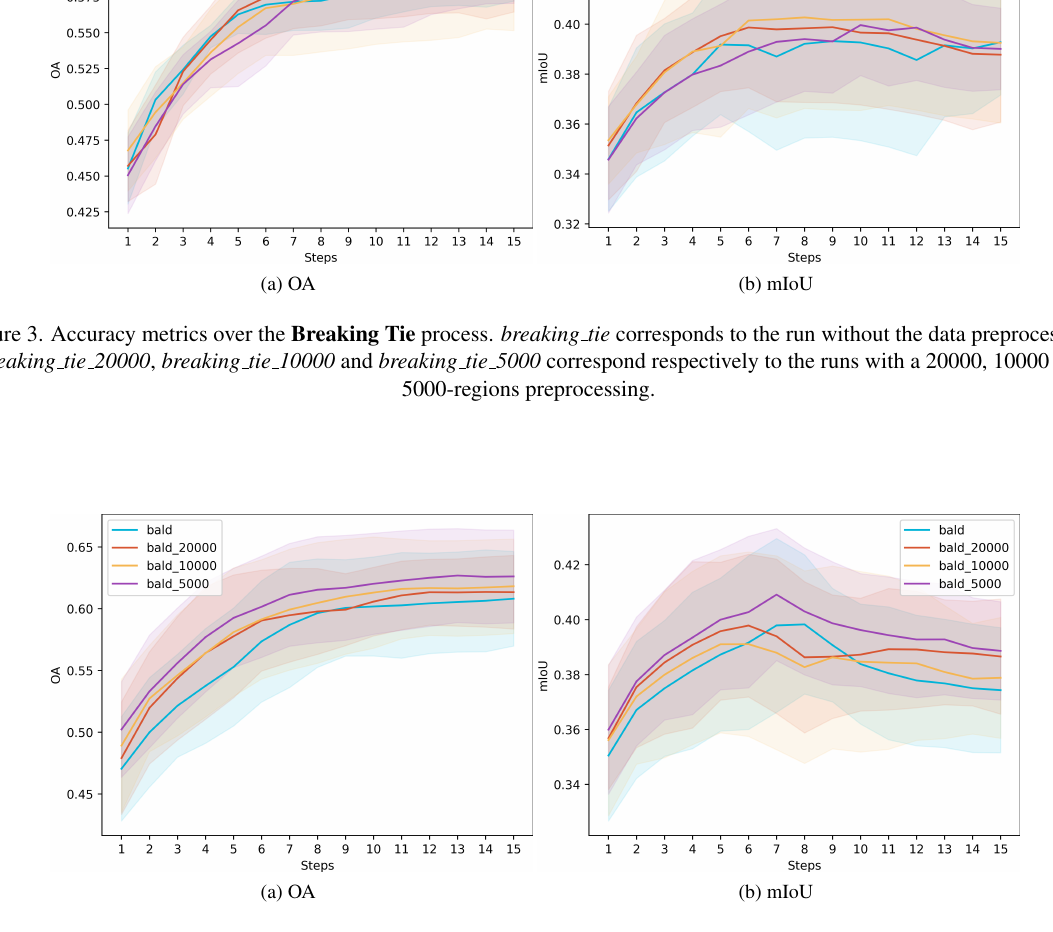
Figure 4. Accuracy metrics over the BALD process. bald corresponds to the run without the data preprocessing. bald 20000 , bald 10000 and bald 5000 correspond respectively to the runs with a 20000, 10000 and 5000-regions